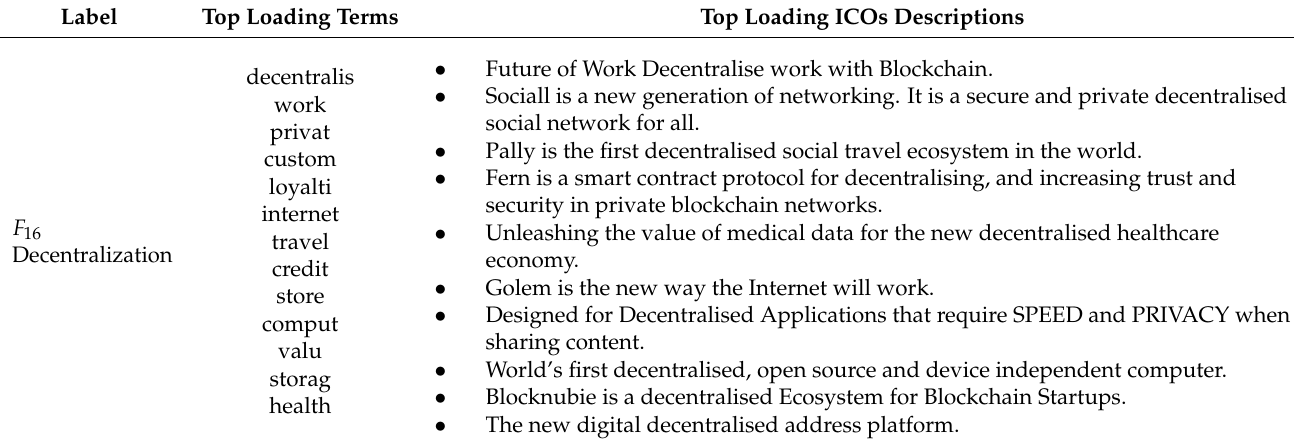
Table A16. Decentralization.